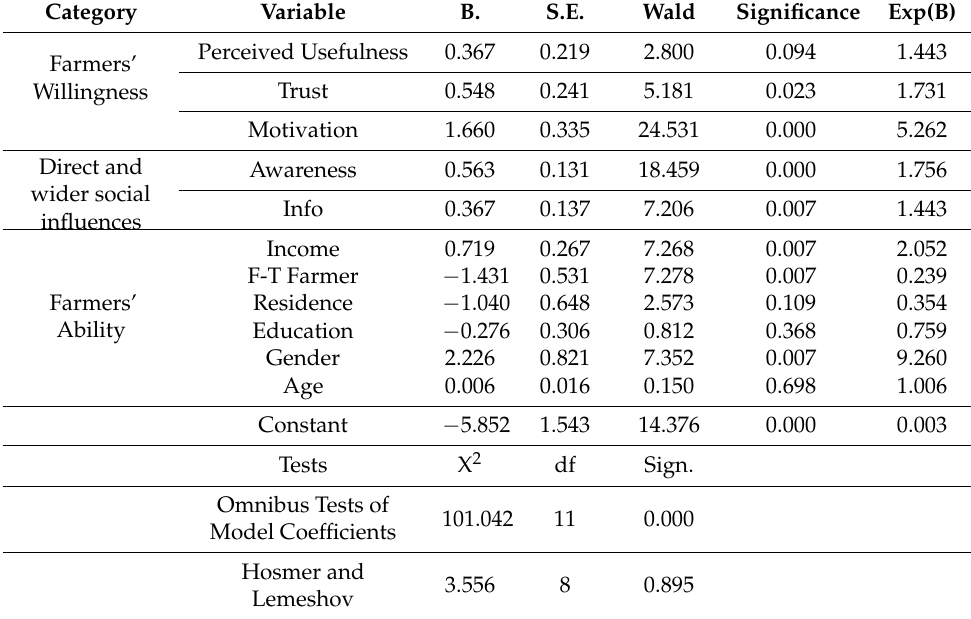
Table 5. Results of the binomial logistic regression